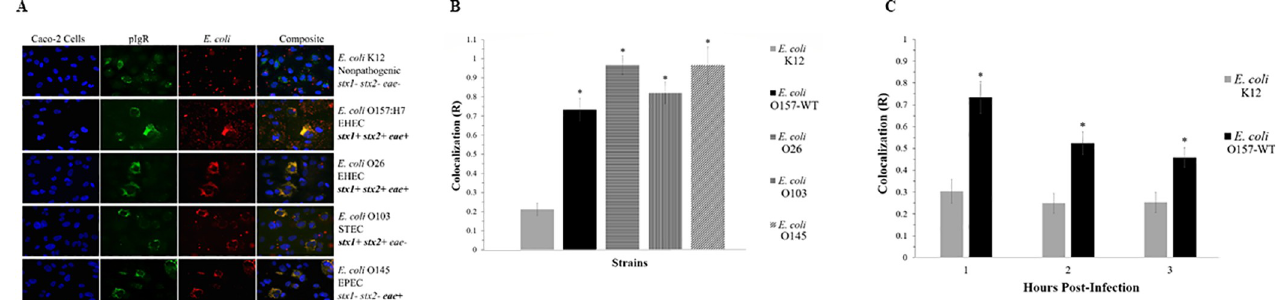
Fig 2. Colocalization of pIgR with E . coli strains during initial adherence. (A) Colocalization of pIgR with E . coli strains at 2 h post-infection. Fluorescent signals of Caco-2 nuclei, Hoechst stain with emission at 497 nm, shown in blue; fluorescent signals of E . coli , DyLight 594 with emission at 594 nm, shown in red; fluorescent signals of pIgR protein, DyLight 488 with emission at 488 nm, shown in green; colocalization of pIgR protein with E . coli K12 and O157-WT (B) Colocalization of pIgR with E . coli strains, and (C) pIgR with E . coli K12 and O157-WT over time. Statistical significance, shown as � , was as compared to the E . coli K12 control at the same time points. P -values < 0.05 were considered significant.